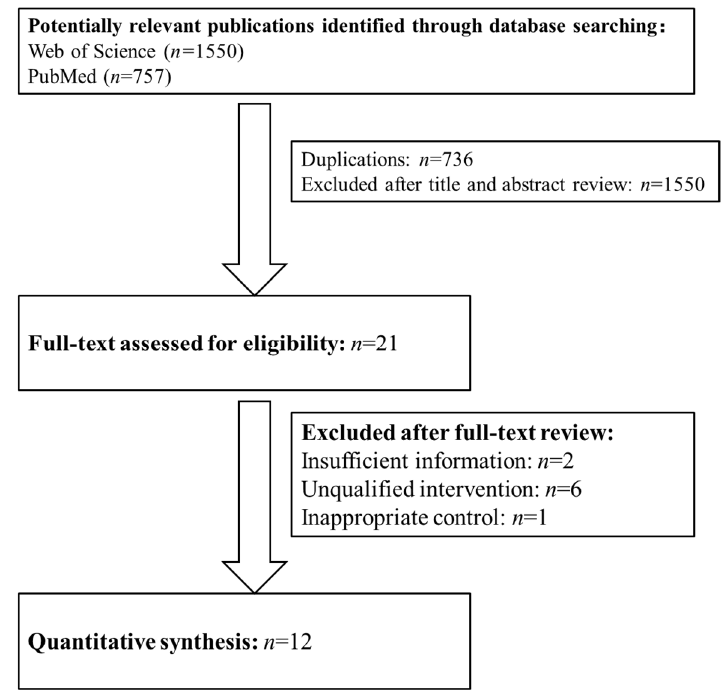
Figure 1. The flow diagram of trial selection.